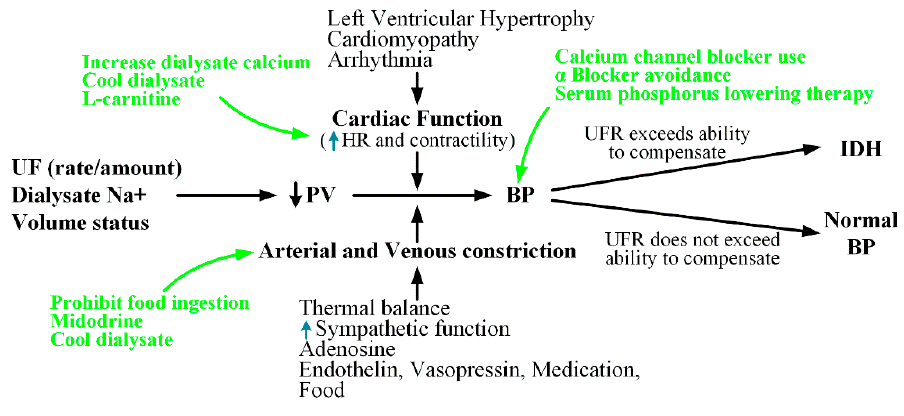
Figure 2. Pathophysiology of IDH ([33]).